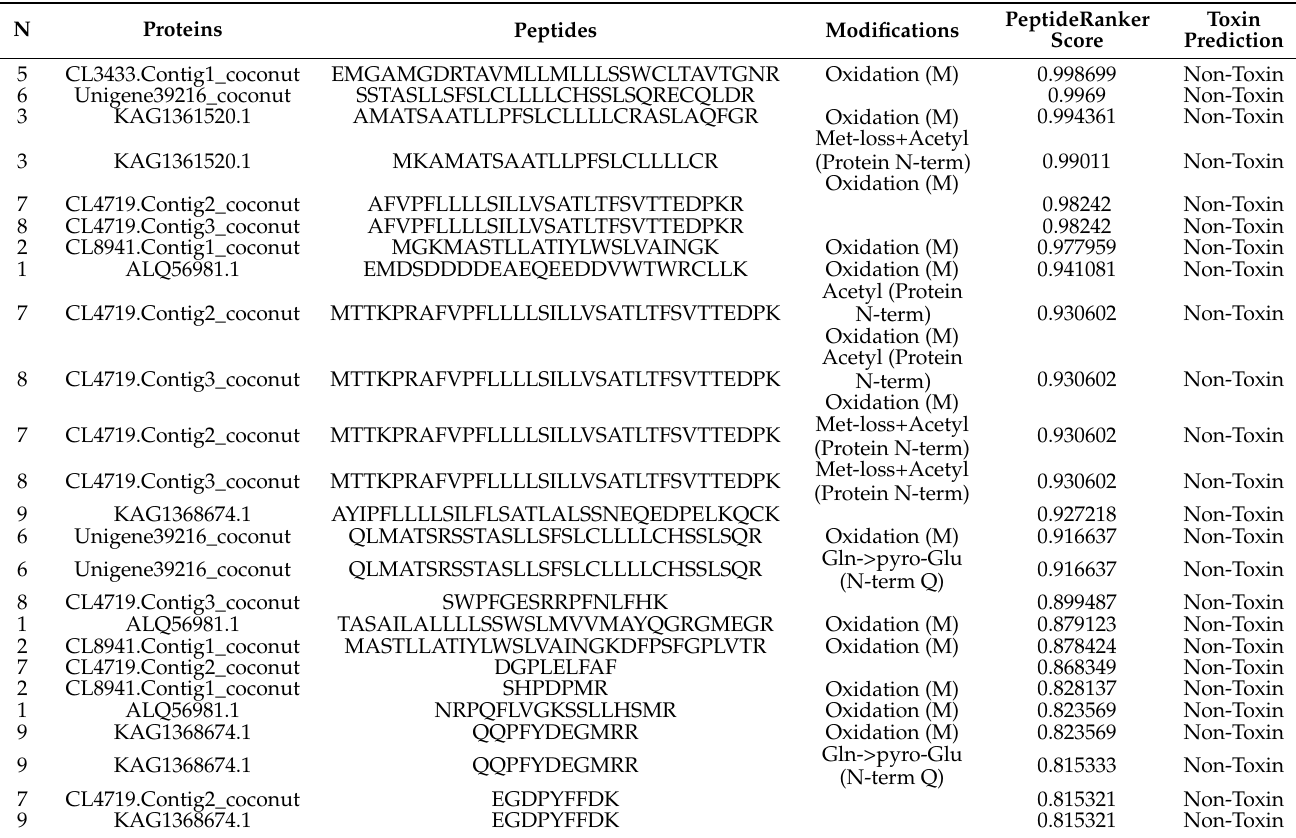
Table 4. Selected potential bioactive peptides of the globulin predicted by in-silico digestions with trypsin.